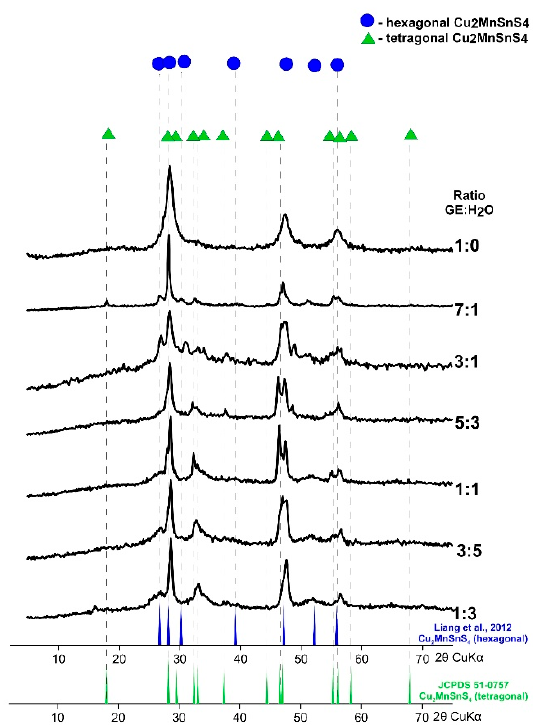
Figure 2. Powder X-ray diffraction pattern of Cu 2 MnSnS 4 (CMTS) nanoparticles synthesized at various EG:H 2 O ratios. As the water content increases, the peaks characteristic of the hexagonal structure become clearer.